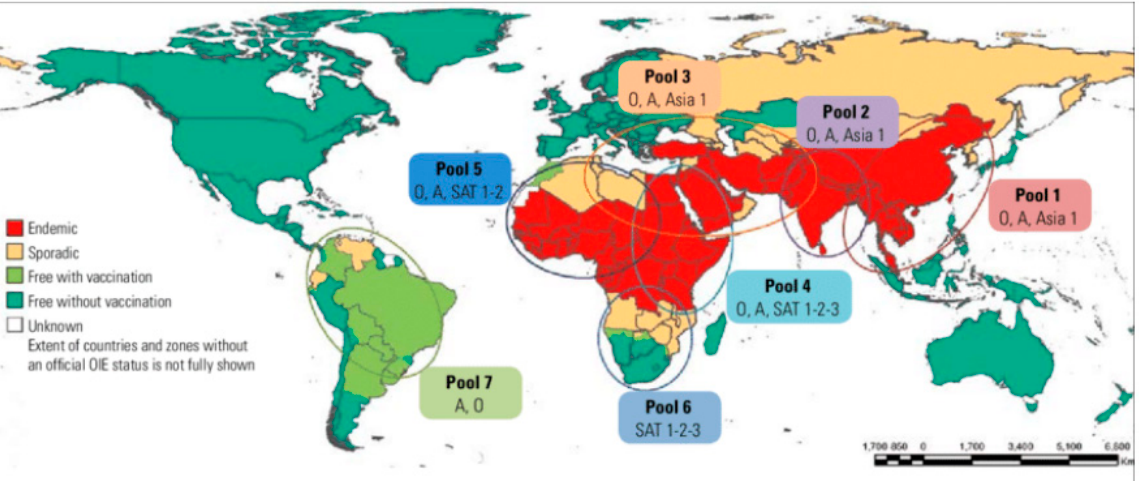
Figure 1. World map showing the distribution of foot-and-mouth disease (FMD) virus pools by serotype (source:) (reprinted and Adapted from [37].